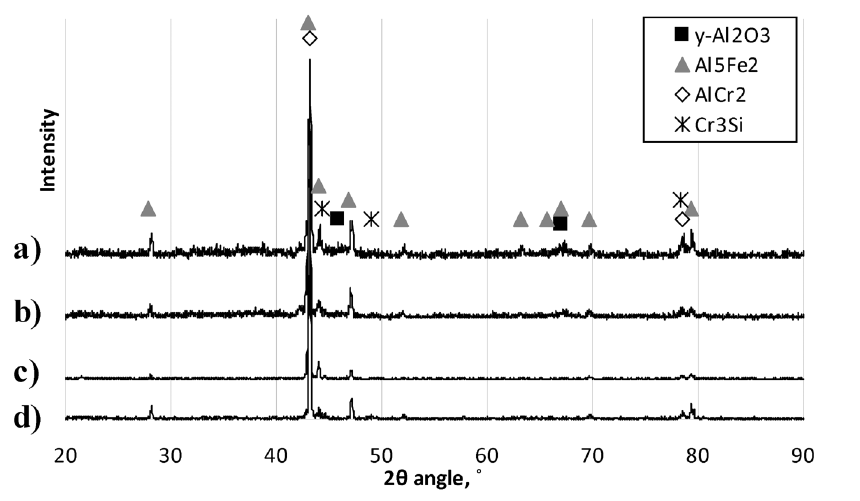
Figure 10. XRD spectra for aluminized specimens after 336 hours exposure under test conditions indicated in brackets